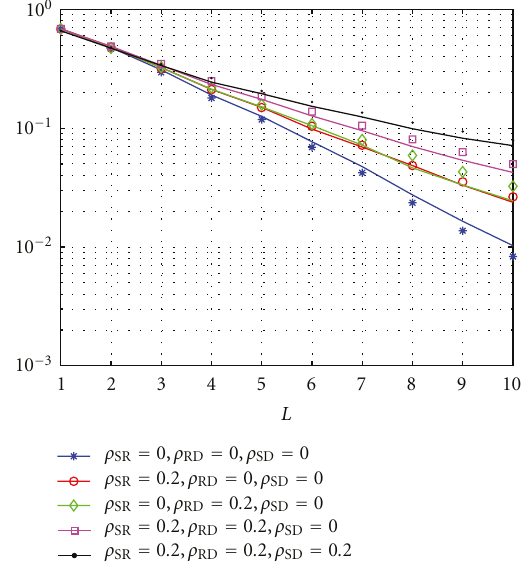
Figure 7: Probability of not detecting a PU ( P m ) against the number of cooperating CRs (L). The curves are obtained for di ff erent values of the correlation coe ffi cient of the shadow fading over the sensing channel ( ρ SR ), the reporting channel ( ρ RD ), and pairs of links on the sensing and reporting channels ( ρ SD